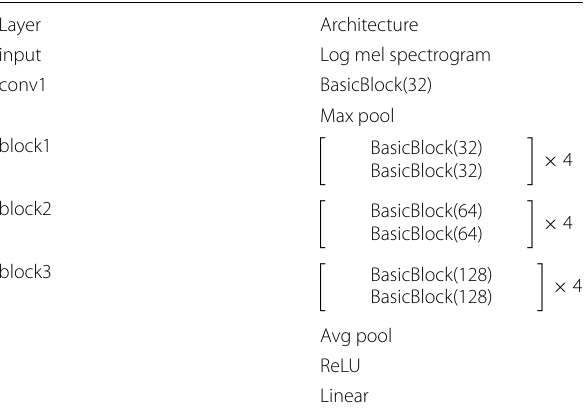
Table 2 Architecture of Wide ResNet28-2. Downsampling is performed by the first layers in block2 and block3 Layer